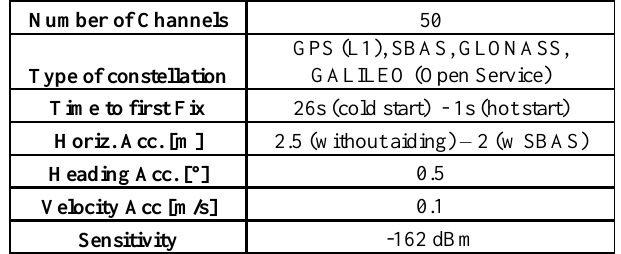
Table 1 Main performance of the GPS module u-blox 6H